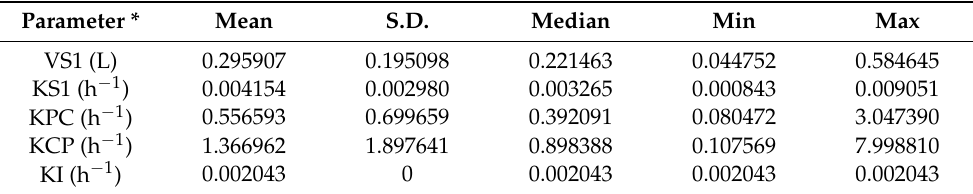
Table 2. Pharmacokinetic parameters used for predictions **. Parameter *